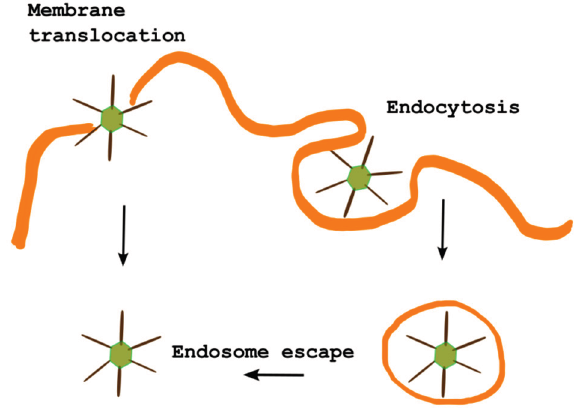
Figure 1. Mechanism of internalization of gH625 coupled to a cargo. In yellow are reported membrane bilayers, in green the cargo and in black the